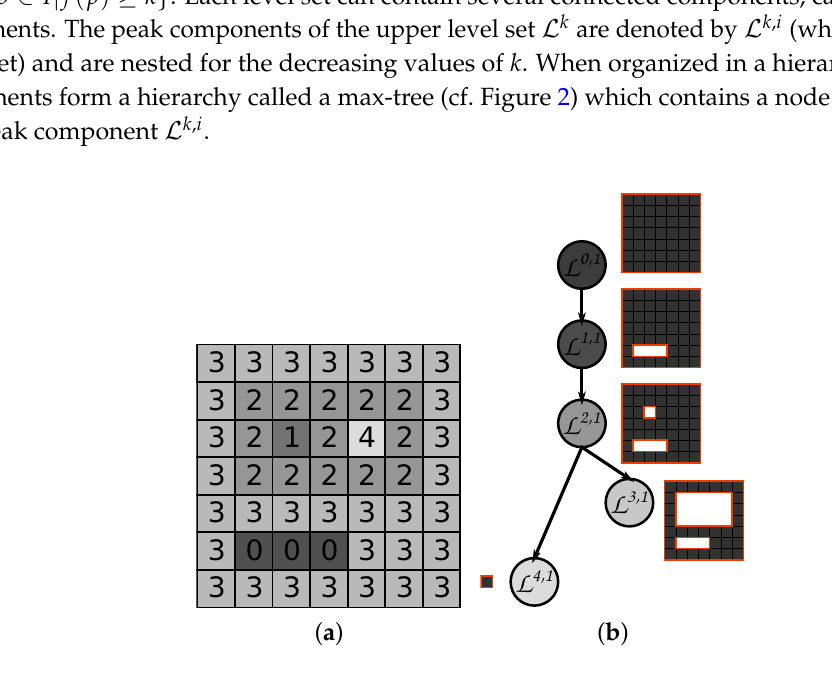
Figure 2. The max-tree for the shape in ( a ) is displayed in ( b ). The regions corresponding to the nodes are displayed besides them, with the level sets indicated inside the